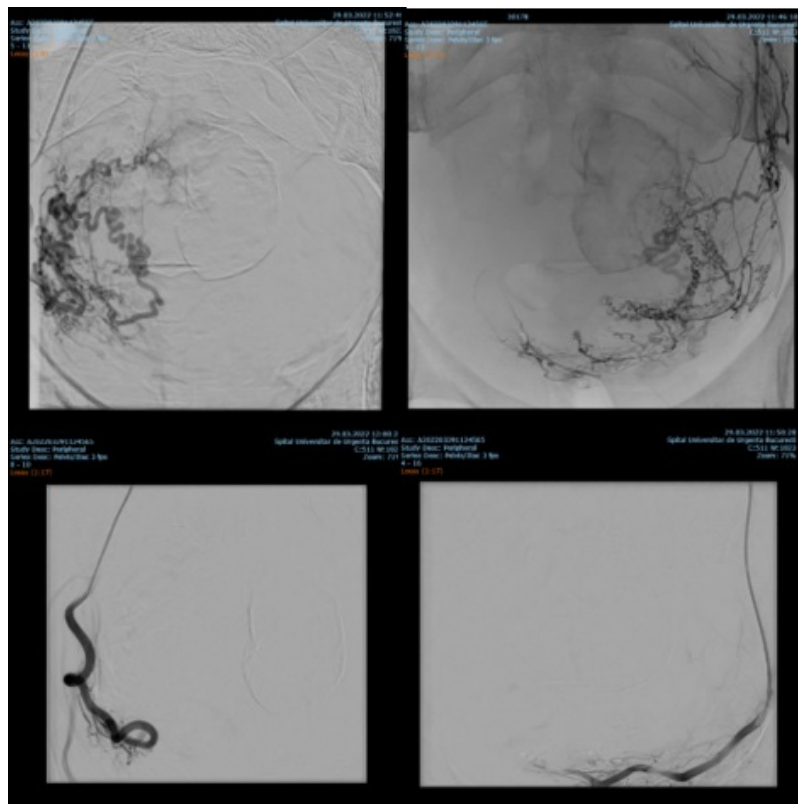
Figure 2. Selective artery embolization in patient with cervical neoplasia.